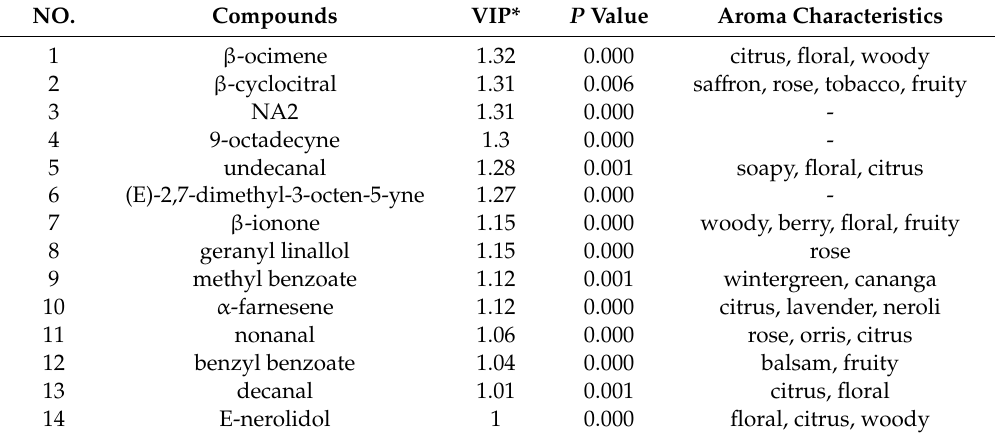
Table 1. Characteristics of the 14 key VOCs in the PLS-DA